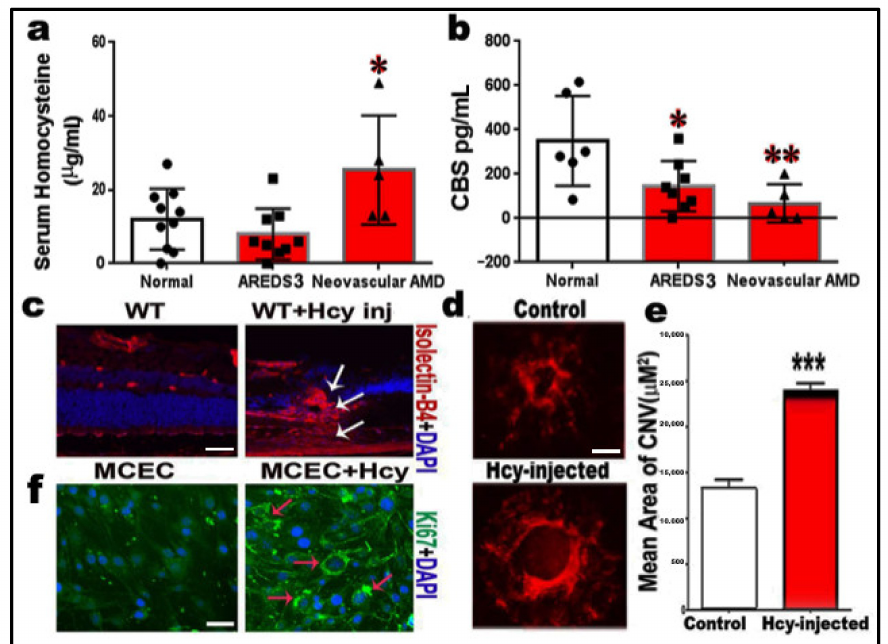
Figure 1. Homocysteine promotes angiogenesis and induces choroidal neovascularization (CNV). ( a ) ELISA measurement of serum Hcy showing a significant increase in patients with neovascular AMD. ( b ) ELISA measurement of serum CBS enzyme showing a significant decrease in patients with neovascular AMD. ( c ) Intravitreal injection of Hcy in wild-type mice induced choroidal neo- vascularization (CNV), as shown in retinal sections stained with isolectin-B4 (Arrows) ( n = 6 mice per group). ( d ) Flat-mount retina stained with isolectin-B4. ( e ) Statistical analysis for the CNV size, showing that Hcy significantly increased the extent of laser-induced CNV in wild-type mice. ( f ) Immunofluorescence staining showing a marked increase in the immunoreactivity of the pro- liferation factor Ki67 in cultured mouse choroidal endothelial cells (green) by Hcy treatment ( n = 4). Calibration bar: 50 µ m; * p < 0.05, ** p < 0.01, and *** p < 0.001. Symbols (dark circles; represent number of normal patients, squares, represent number of AREDS patients and the triangles; represent the number of neovascular AMD